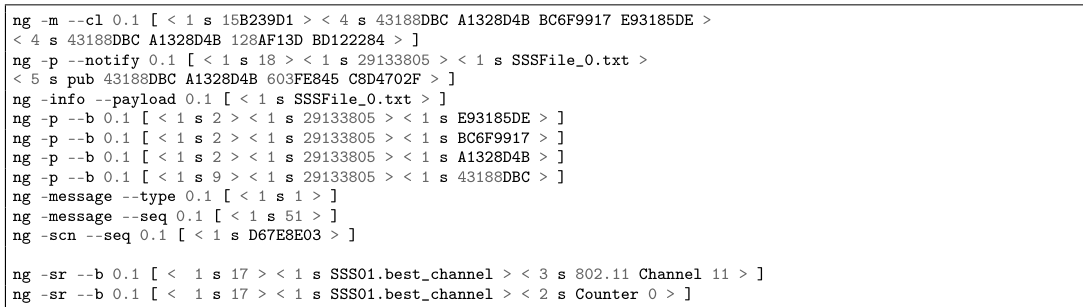
Figure 17. Capture of a NG message from RMS to APS using Wireshark TM . In Figure 17, we reproduce a Wireshark TM capture of a NG message from RMS to APS requiring 727 a channel change to channel 3. The control command is in the payload area of the message (latest 728 bytes). For this test, the frame Type was configured to 0x1234, which is unknown for Wireshark. The 729 mean round trip time (RTT) for subscribing such command messages at APS is depicted in Figure 18. 730